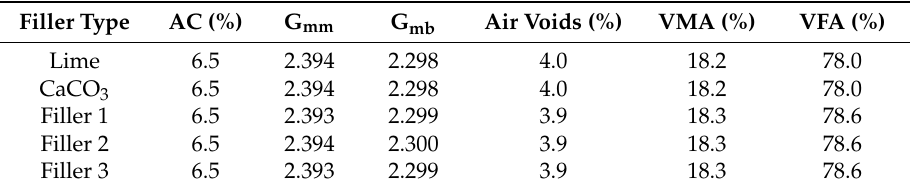
Table 4. Volumetric properties of the SMA mixtures.